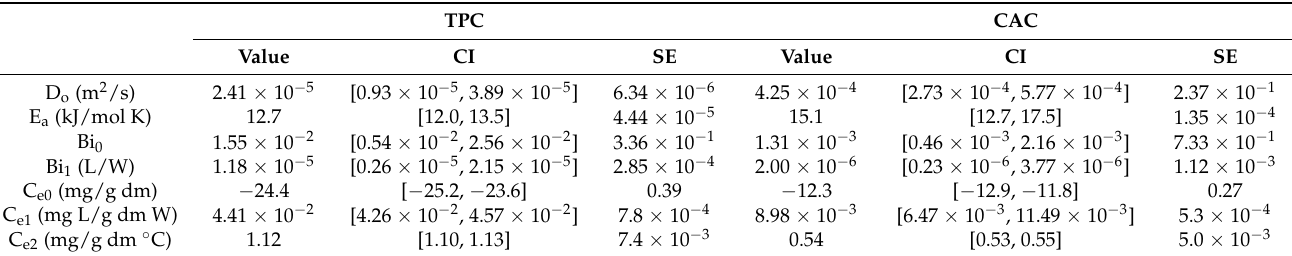
Table 2. Identified parameters for the proposed model and confidence interval (CI) and standard error (SE) for each parameter. Extraction of total phenolic content (TPC) and chlorogenic acid content (CAC) from artichoke stem at different temperatures under agitation and acoustic